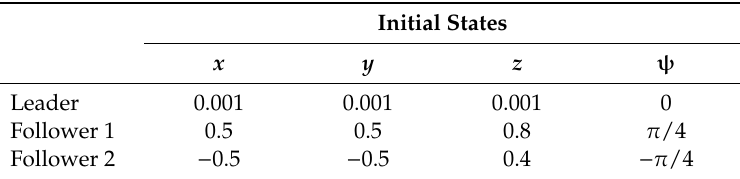
Table 9. Achieving consensus test initial